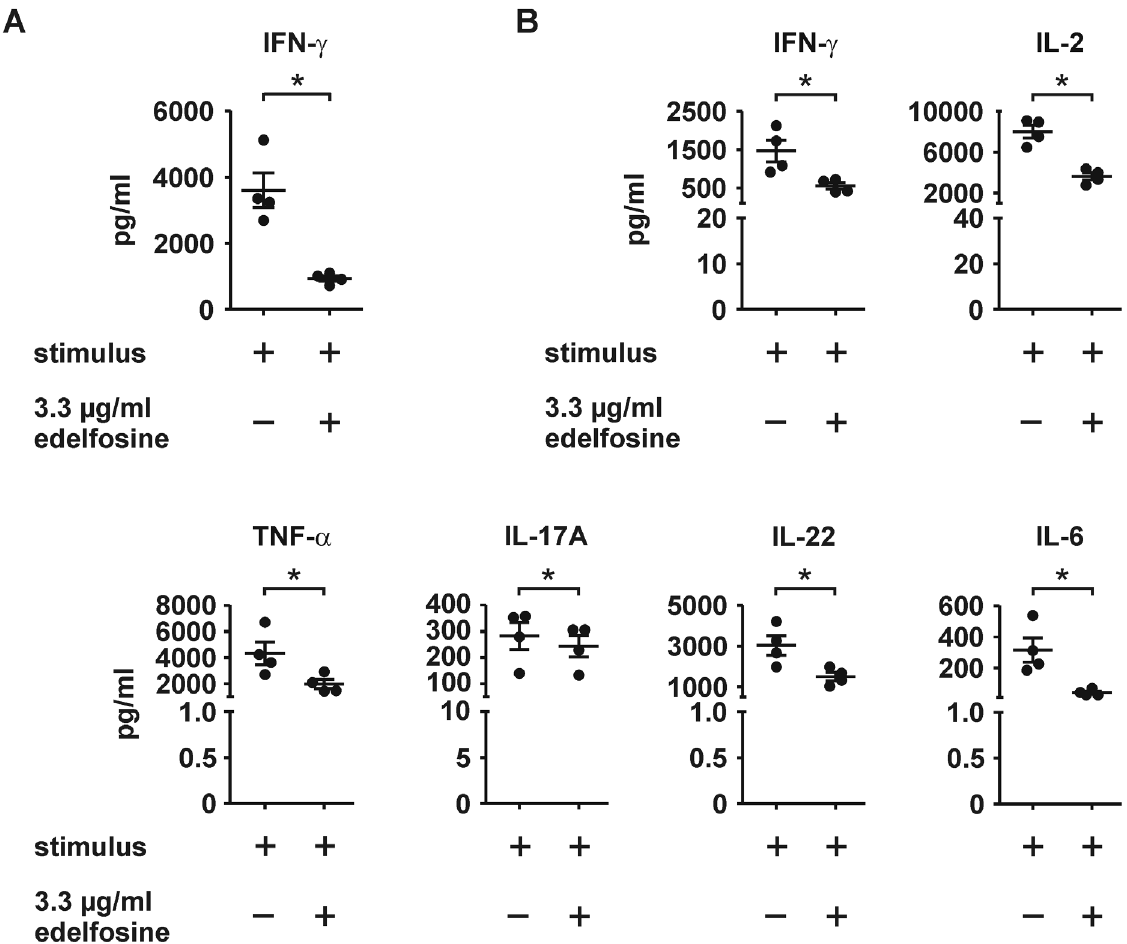
Figure 5. Cytokine secretion was modulated in activated CD4 + T cells by edelfosine. (A) By ELISA, a significant reduction of IFN- c -secretion was monitored upon edelfosine treatment. (B) This result was confirmed by a human 13plex kit which allowed the detection of not only reduced concentrations of IFN- c in supernatants of edelfosine-treated cells, but also reduced concentrations of the Th1-associated cytokines IL-2 and TNF- a as well as the Th17-associated cytokines IL-17A, IL-22 and IL-6. Cells of four individuals (age-matched, two males and two females) were used, error bars indicate SEM of respective means (*P , 0.05 after paired t-tests).